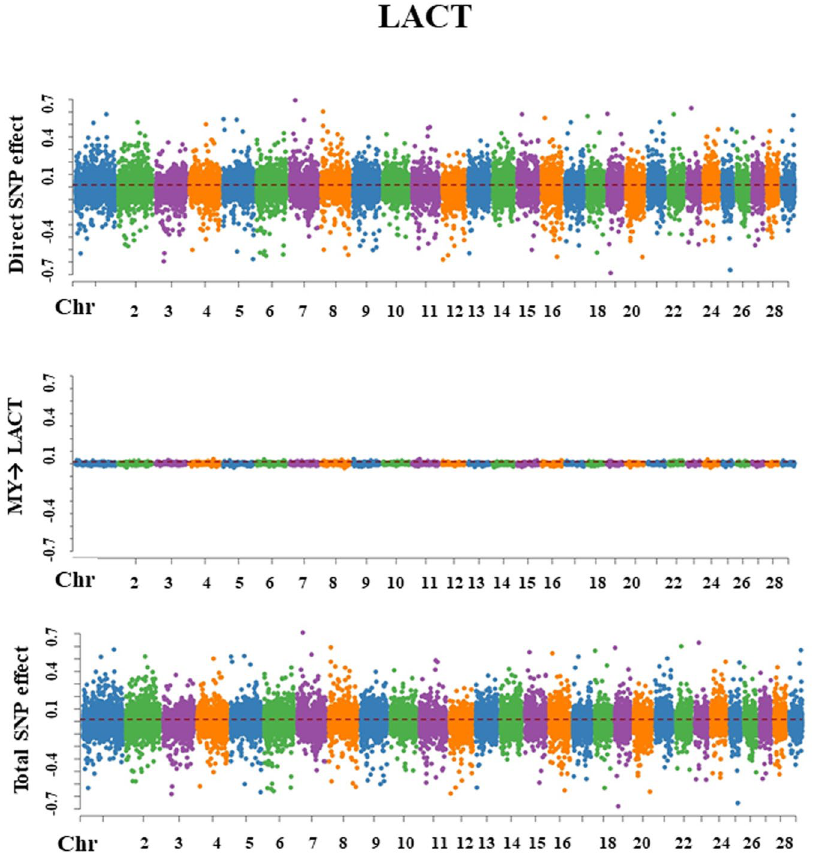
Figure 4. Manhattan plots for SNP effects on milk lactose obtained using SEM-GWAS based on the network structure learned by Hill-Climbing algorithm. LACT: lactose; MY: milk